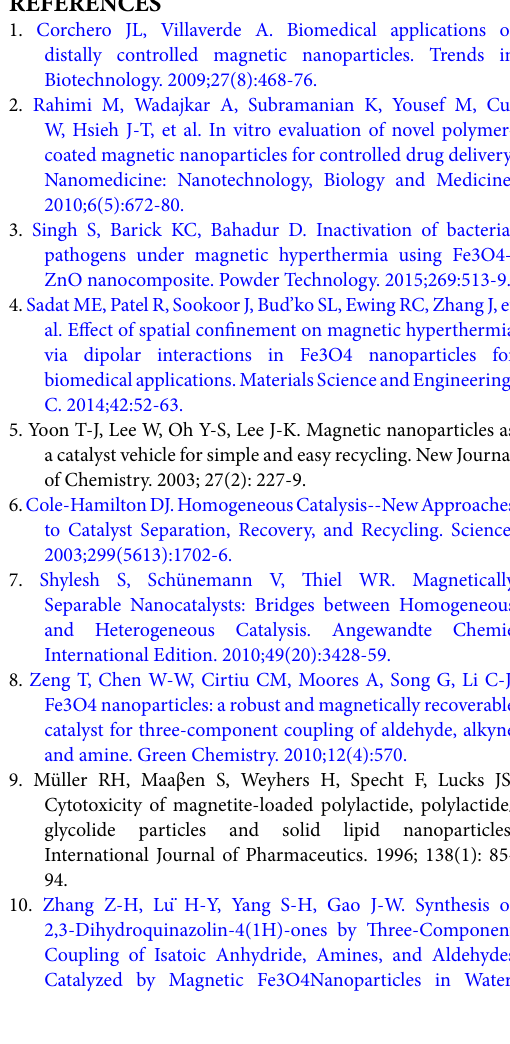
Table 4: Comparison of the efficacy of Fe 3 O 4 MNPs with some of those reported in the literature Compounds Catalyst Time Yeild Ref.